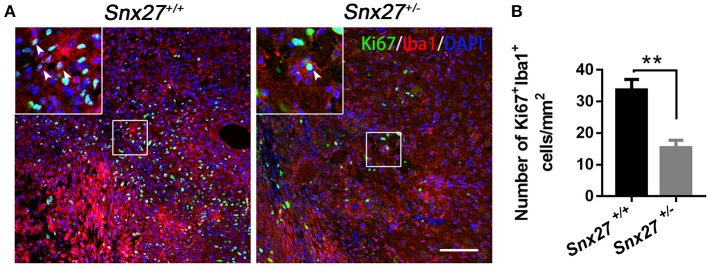
SNX27 haploinsufficiency suppresses the proliferation of macrophage/microglia after SCI. (A) Immunohistological analysis of horizontal spinal cord sections from Snx27+/+ mice and Snx27+/− mice 7 days post injury using antibodies against Iba1 and Ki67 in horizontal sections. Arrowheads indicate Ki67+Iba1+ cells. (B) Quantification of Ki67+Iba1+ cells at the area which is ranging from rostral 400 μm (−400 μm) to caudal 400 μm (+400 μm) around the LC, n = 3. Values are expressed as mean ± SEM and were evaluated by Student's independent sample t-test. **p < 0.01.